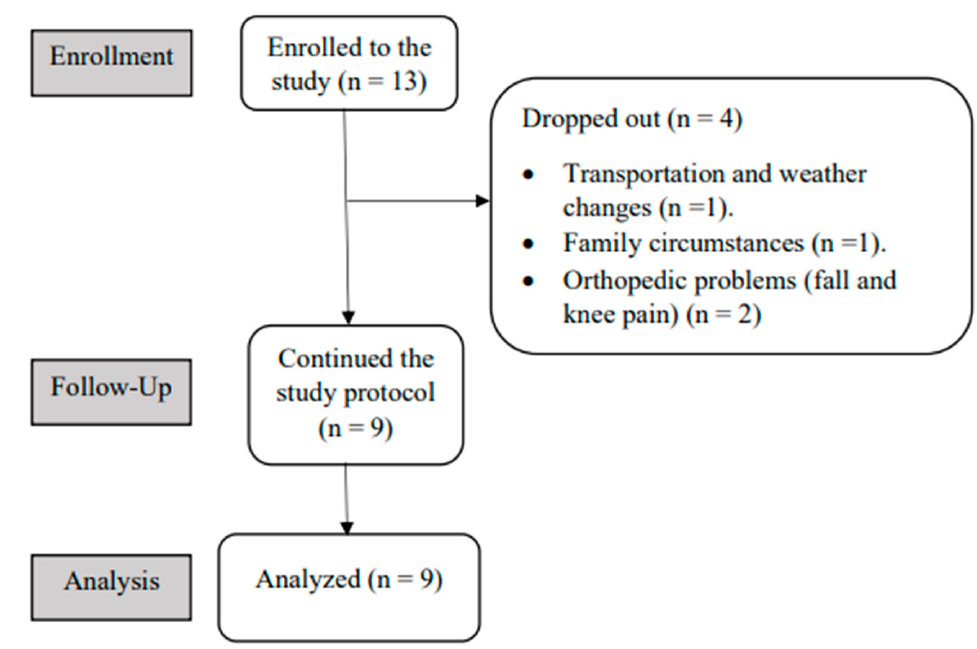
Figure 2. The flow of the study diagram.